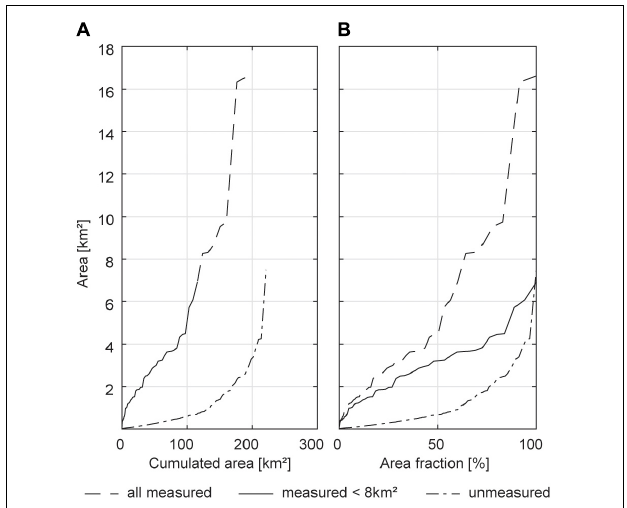
FIGURE 5 | Cumulative glacier area distribution (A) in absolute numbers, and (B) relative to the total area for all glaciers with ice thickness measurements (dashed line), all glaciers with ice thickness measurements smaller than 8 km 2 (solid line) and all glaciers without ice thickness measurements (dash-dotted line).